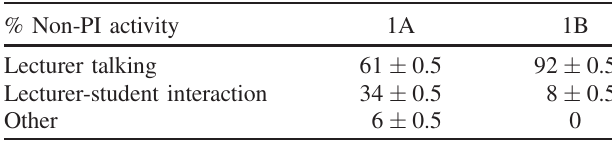
TABLE V. Non-PI activity summary. % Non-PI activity